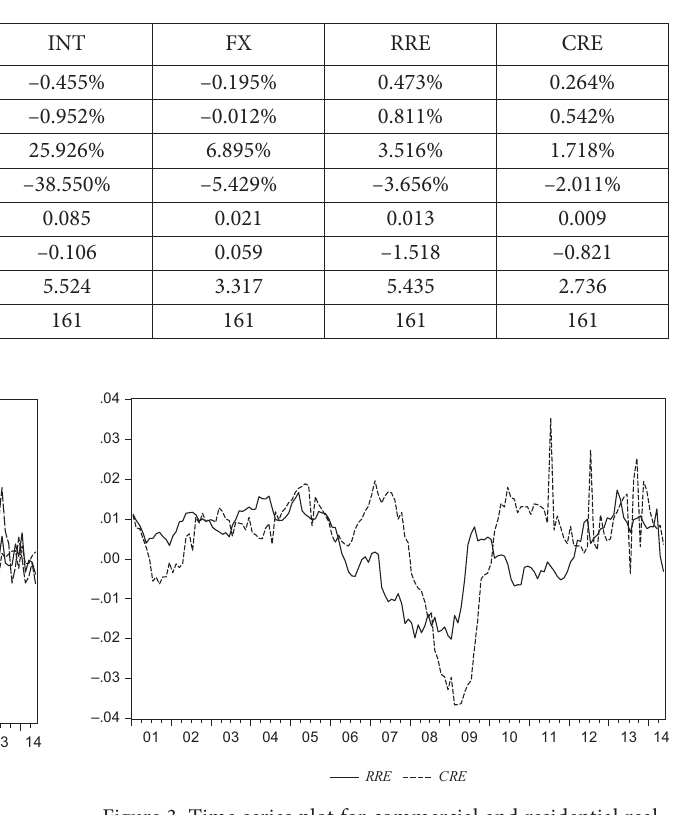
Figure 1. Time series plot for BANK,